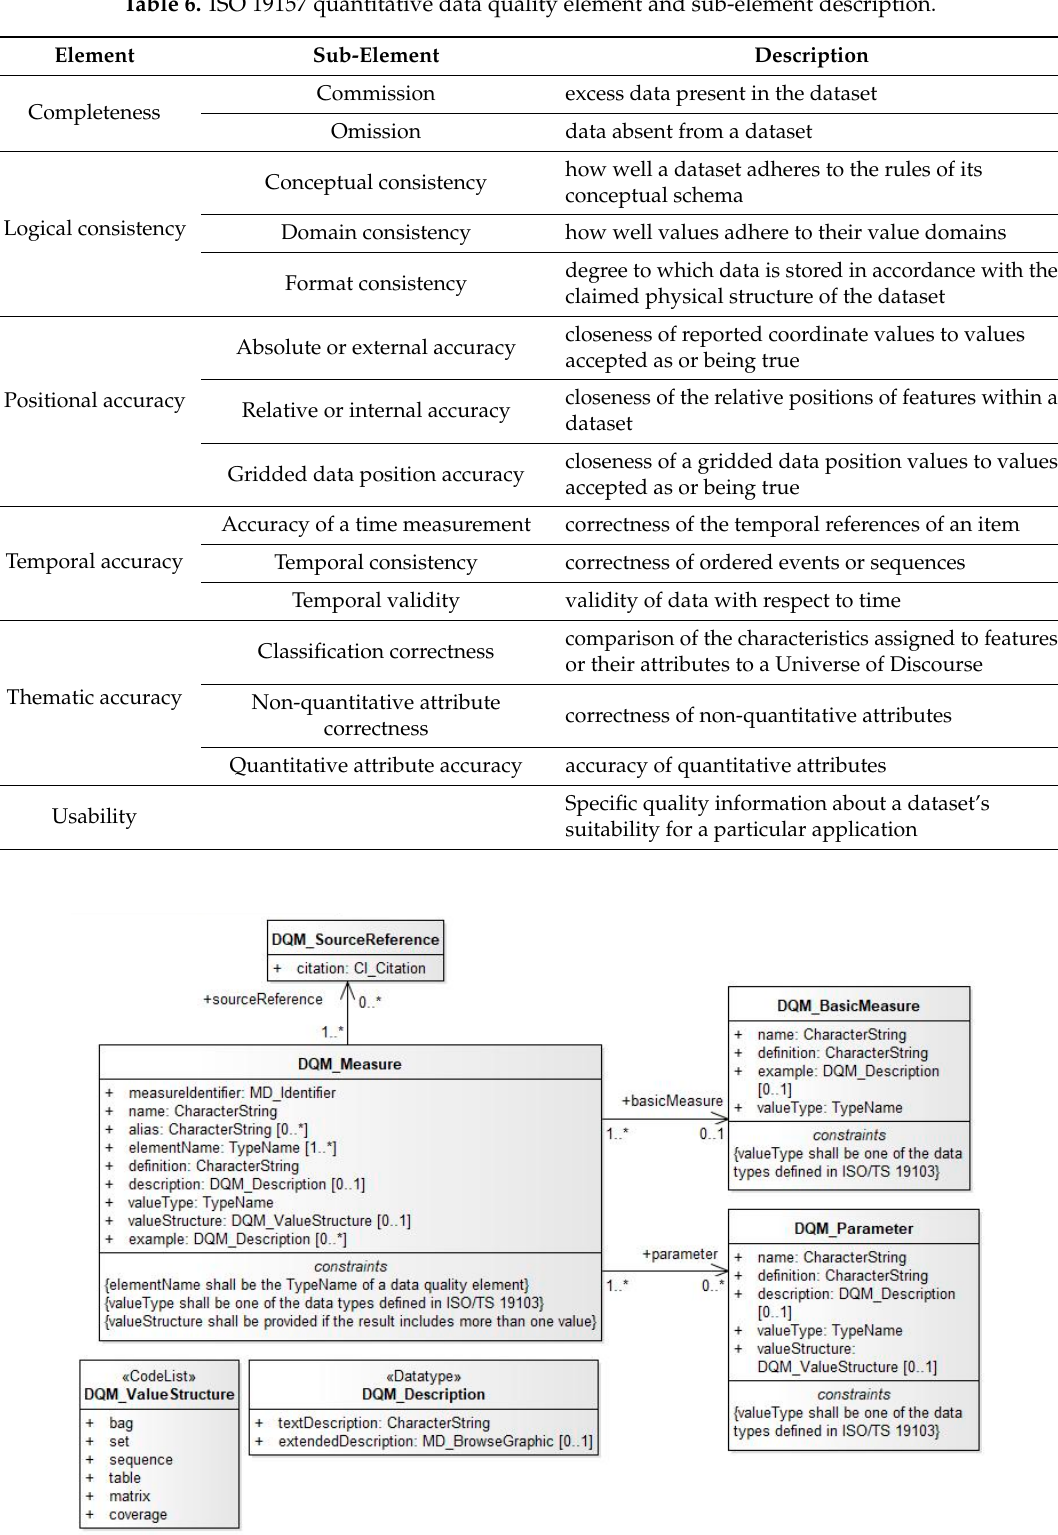
Table 6. ISO 19157 quantitative data quality element and sub-element description.